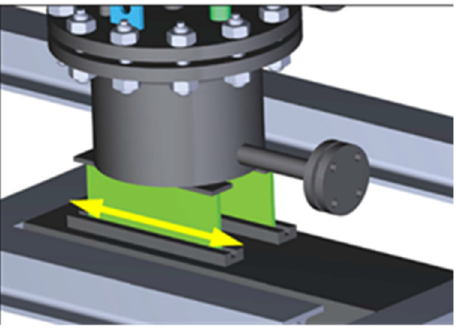
Figure 3. Details of the rail system of the draining tank, which permits movement due to thermal expansion.